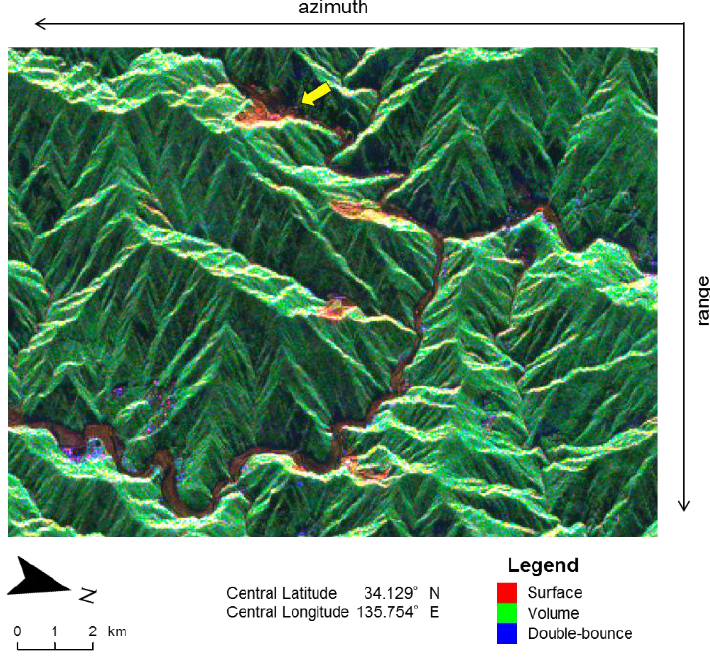
Figure 2. Four-component scattering power decomposition image of a portion in the study area. The PolSAR data for this decomposition image was acquired on 26 August 2014 with PALSAR-2 onboard the ALOS-2 satellite. Deep-seated landslides are colored red, which corresponds to surface scattering. The yellow arrow on the top of the image depicts the line of sight of the optical image of a landslide (Figure 3).